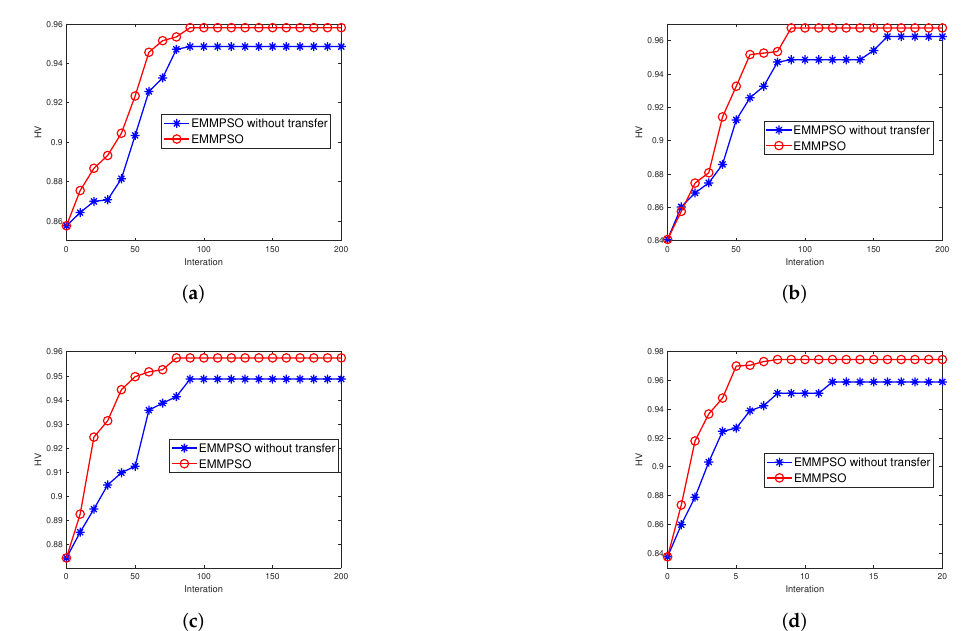
Figure 6. Comparison of the hypervolume indicator for EMMPSO and EMMPSO without transfer. ( a ) task 1 on data 1, ( b ) task 2 on data 1, ( c ) task 3 on data 1, ( d ) task 1 on data 2, ( e ) task 2 on data 2, ( f ) task 3 on data